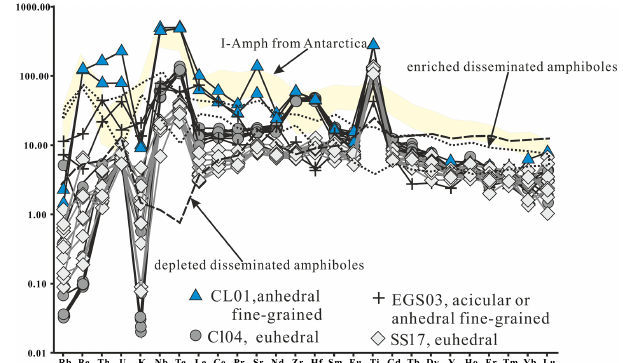
Figure 11. Chondrite-normalized (Sun and McDonough, 1989) incompatible-element spidergram for Changle rhönite. Depleted disseminated amphibole and enriched disseminated amphibole are from the basalt of Kapfenstein, Austria (Coltorti et al., 2007a), and I-Amph (I-amphibole) is from xenoliths from Antarctica (Coltorti et al., 2004,